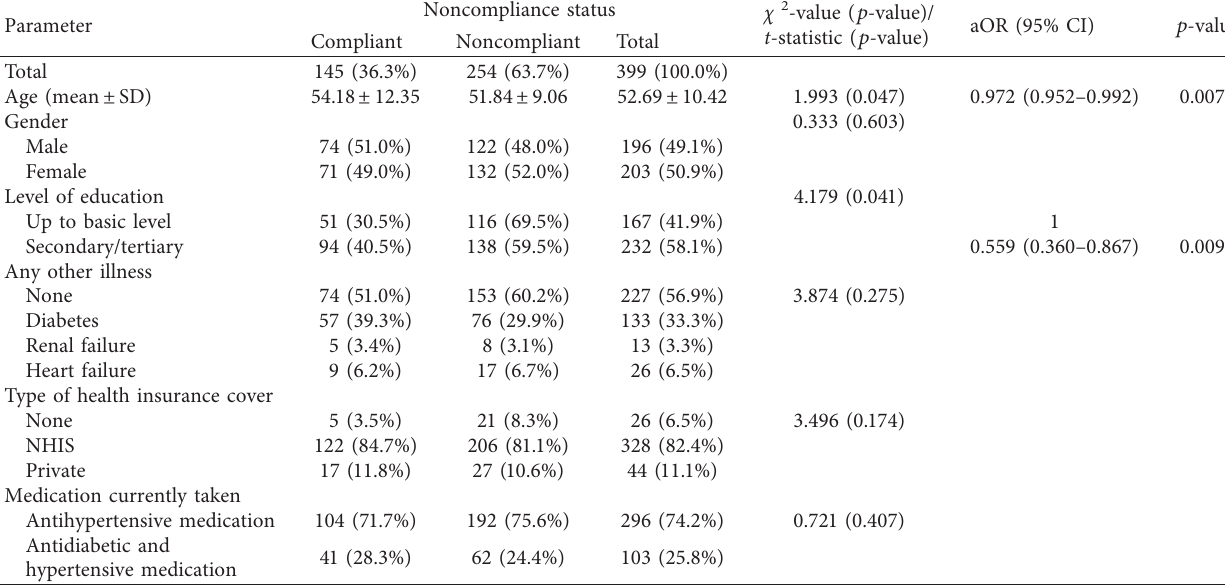
Table 4: Association between sociodemographic characteristics and respondents’ medication